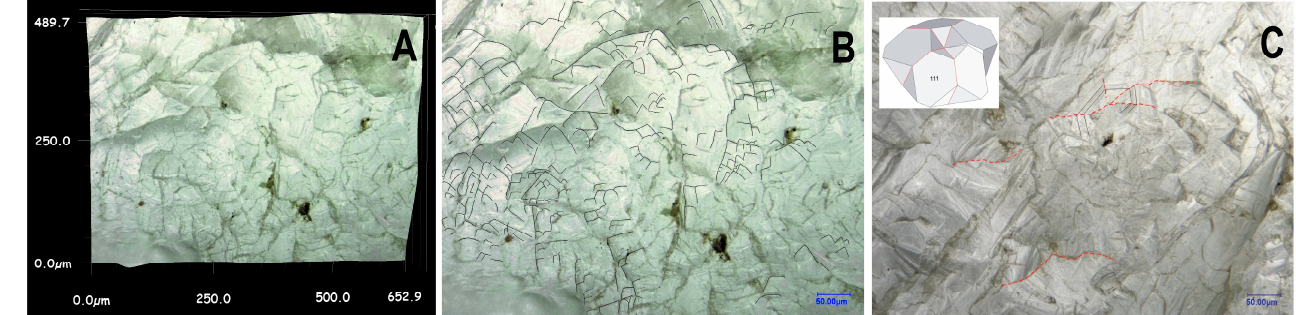
Figure 2. X-ray tomography ( A , C ) and sketch of the principal surface features ( B , D ). ( A , B )—“large” ballas, ( C , D )—“small”.